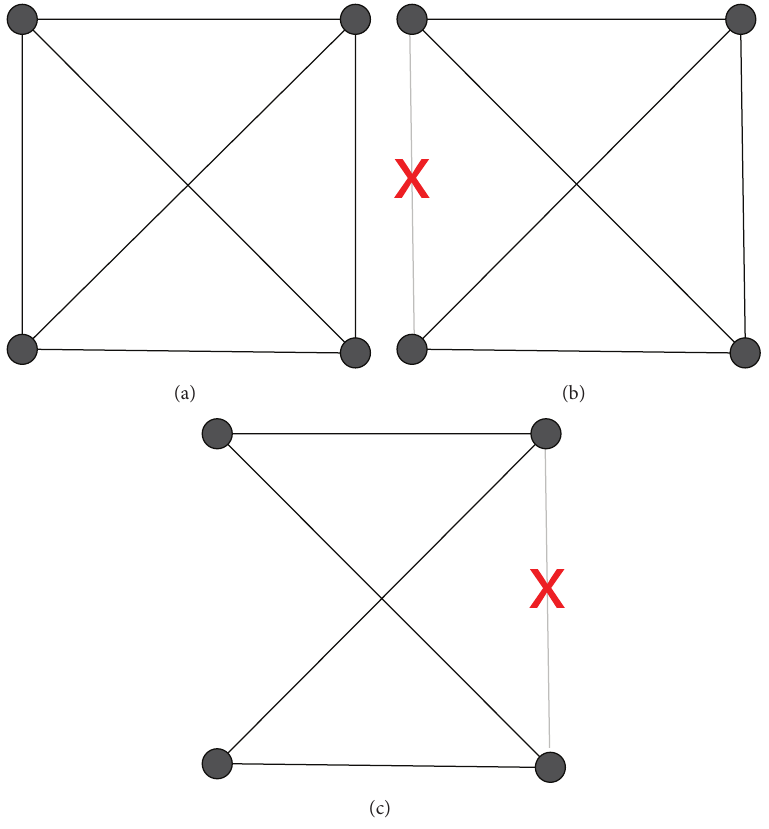
Figure 1: An example for node network